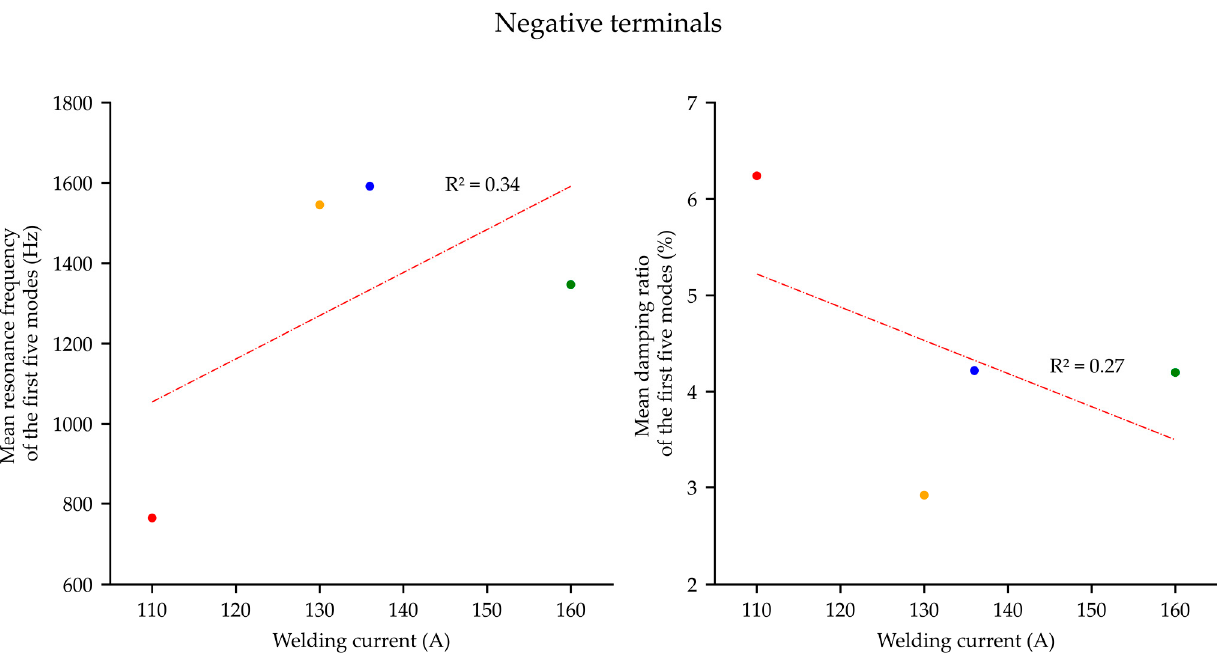
Figure 13. Scatter plots, with the Pearson correlation coefficient, of the mean resonance frequency ( left ) and the mean damping ratio ( right ) of the first five modes, as observed from the negative terminals of the 110 A, 130 A, 160 A, and mixed supercells.